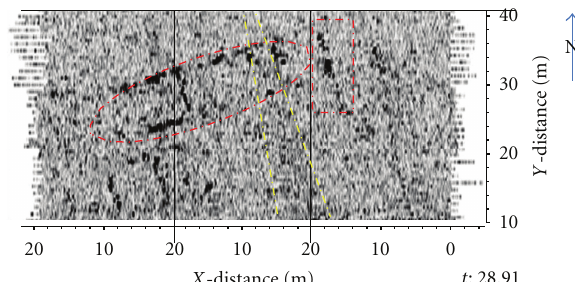
Figure 5: Time slice at c. 29ns (about 123 cm) showing the extant archaeological remains. The corridor between the wings of the villa is put into evidence by the red dashed tilted ellipse, the ditch is outlined by the yellow dashed lines, and the eastern end of the corridor by the dashed red rectangle.